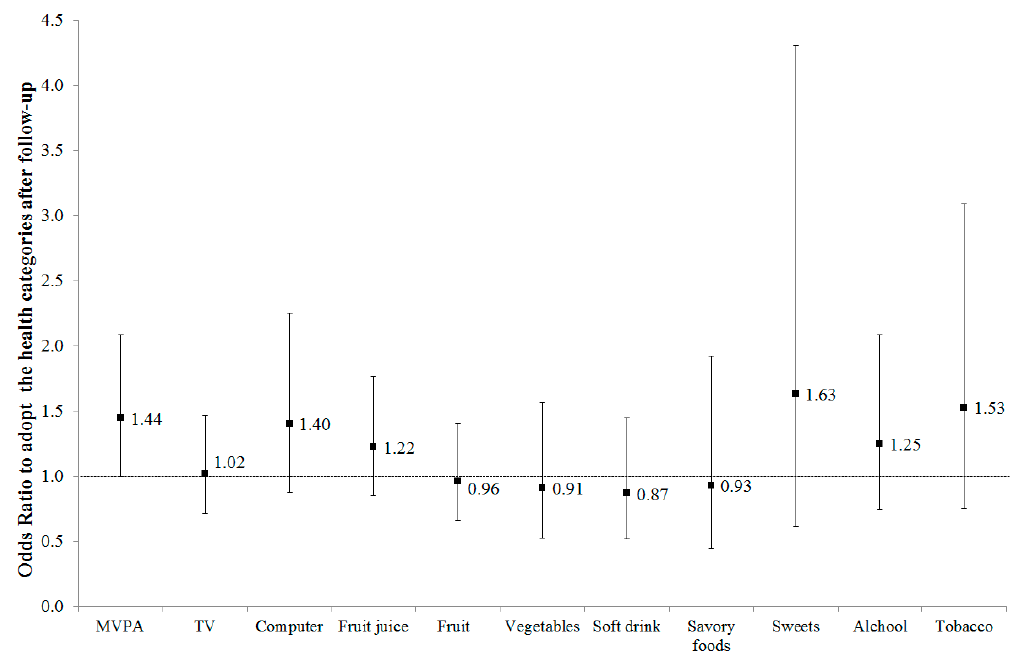
Figure 1. Logistic Regression (Odds Ratio and 95% Confidence Interval) of Intervention Group Adolescents (vs. Control Group Adolescents) Adopting Healthy Lifestyle Factors after Follow-up of the Fortaleça sua Saúde Program, 2014. Note: MVPA: moderate-to-vigorous physical activity. Logistic regression adjusted by gender, age, socioeconomic status and lifestyle factor at baseline and clustering by school.